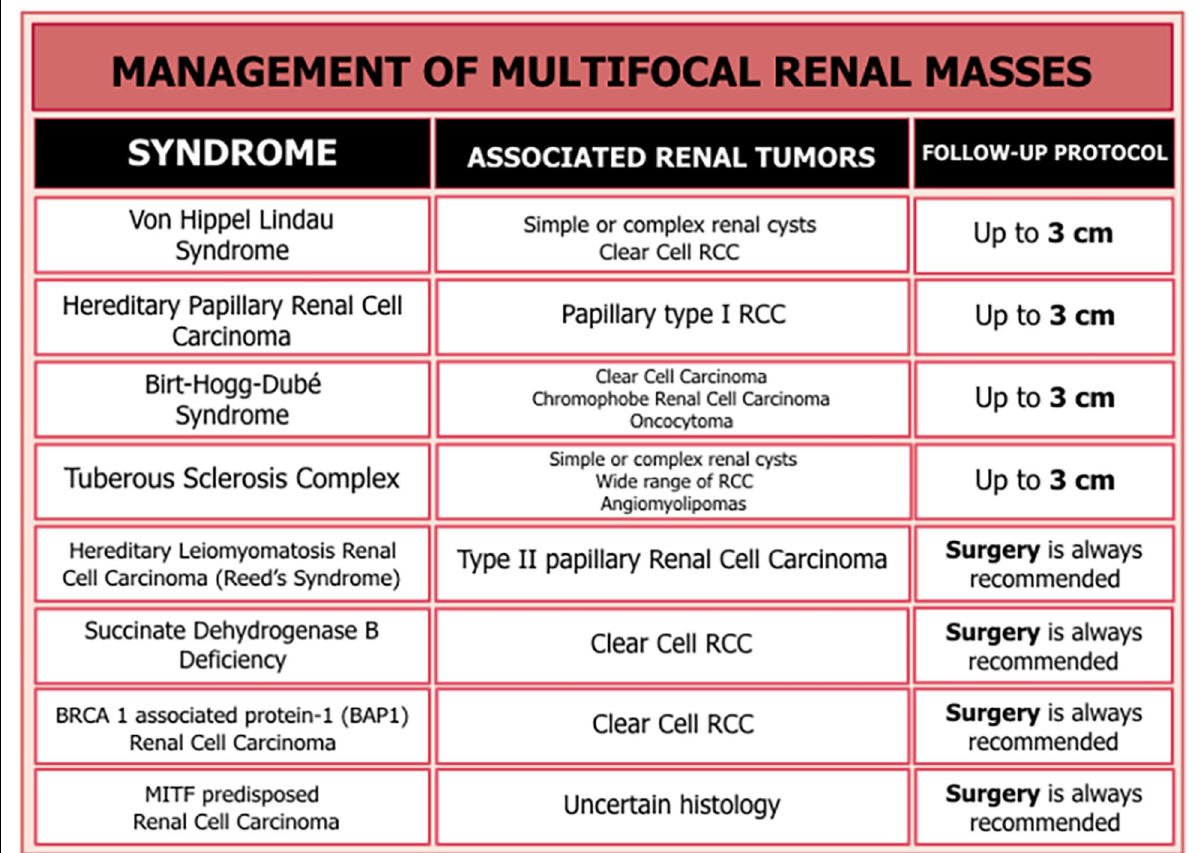
Fig. 21 Multifocal small renal masses (SRM), genetic syndromes classification, type of associated renal tumors, and suggested follow-up by active surveillance